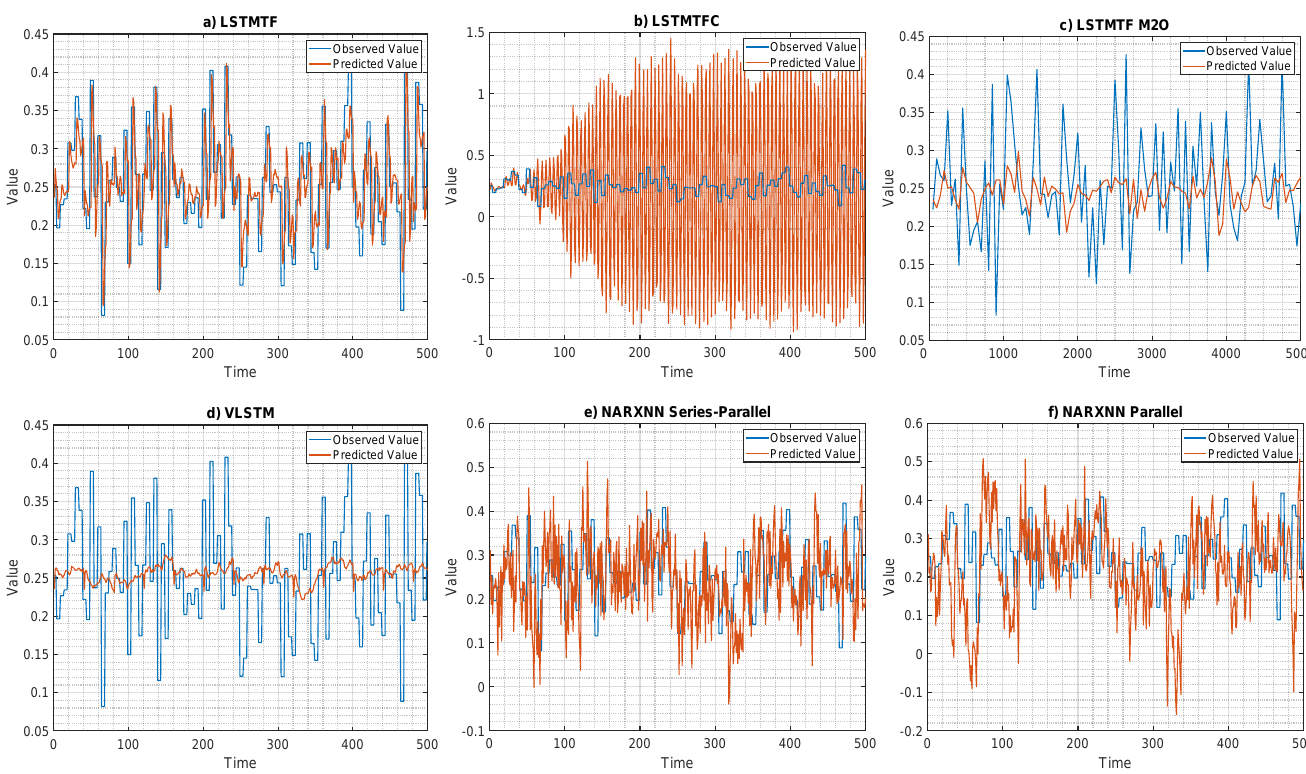
Figure 26. Illustration of the prediction performance for experiment 4. Subfigures ( a , b , d – f ) showcase the observed/predicted values on an entire cycle of 500 observations. Subfigure ( c ) showcases the observed/predicted values for LSTMTF using an M2O prediction mode for 5000